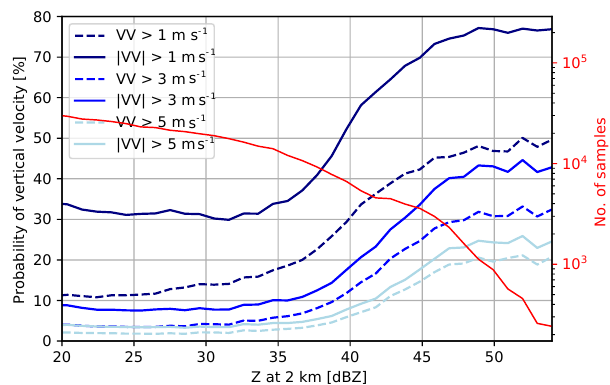
Figure 6. The frequency for observing a given vertical veloc- ity (across all levels, > 1ms − 1 in navy, > 3ms − 1 in dark green, > 5ms − 1 in light green) as a function of a 2km RWP reflectivity. The number of samples (for | V V | > 1ms − 1 ) is displayed as a red